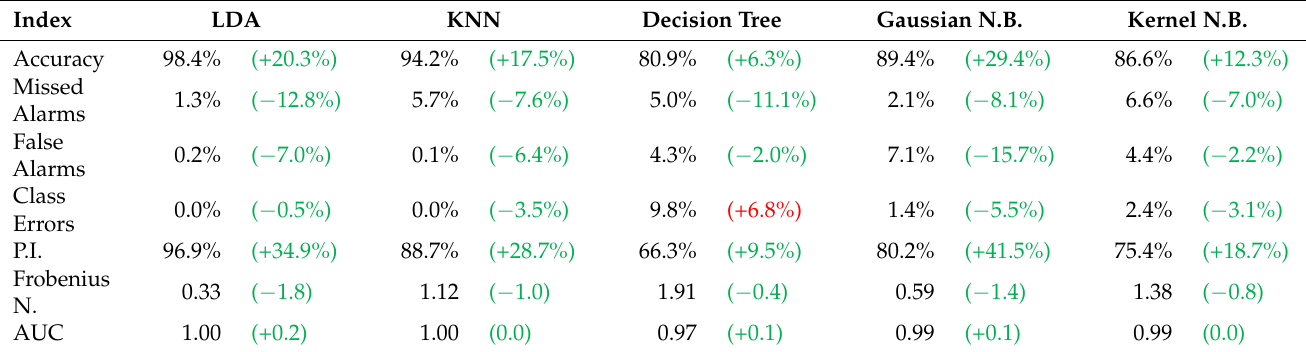
Table 3. Performance indices obtained using k − 1 features calculated with the proposed CCA. The variations with respect to the reference PCA method (in Table 2) are shown in brackets. Please note that the percentage variations highlighted in green represent an improvement (increase in precision and decrease in errors), while those in red indicate a worsening in terms of